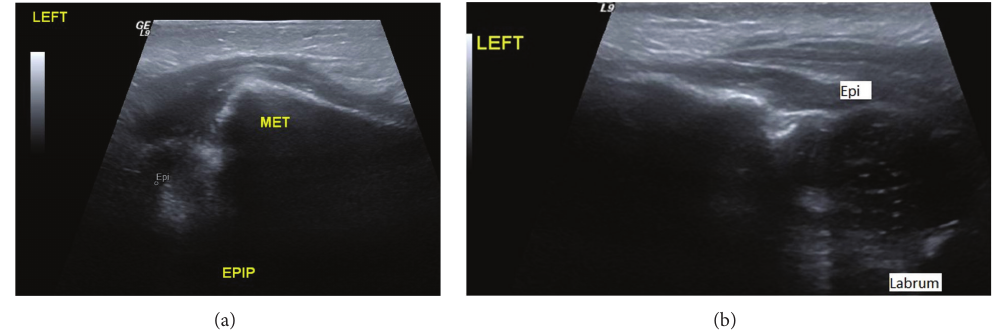
Figure 3: (a) Longitudinal sonogram of the left shoulder demonstrates separation of the left humeral epiphysis (epi) from the metaphysis (met). (b) Transverse sonogram of the left shoulder shows left humeral epiphysis within the confines of the labrum.